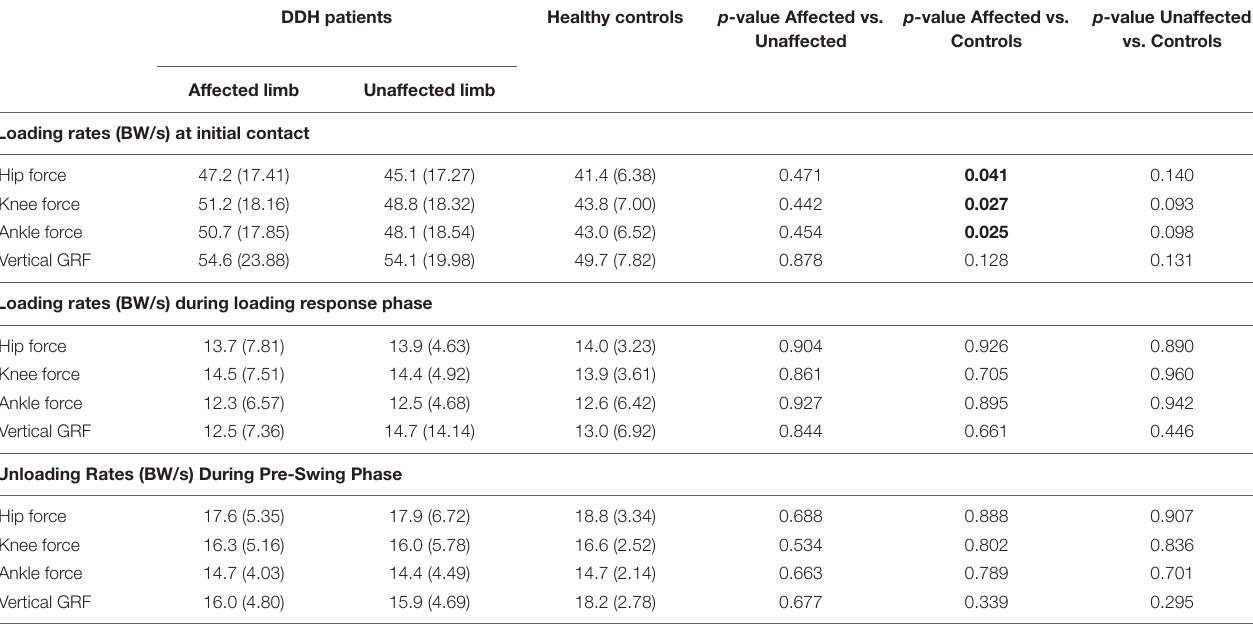
p- value Affected vs. p- value Unaffected Unaffected Controls vs.